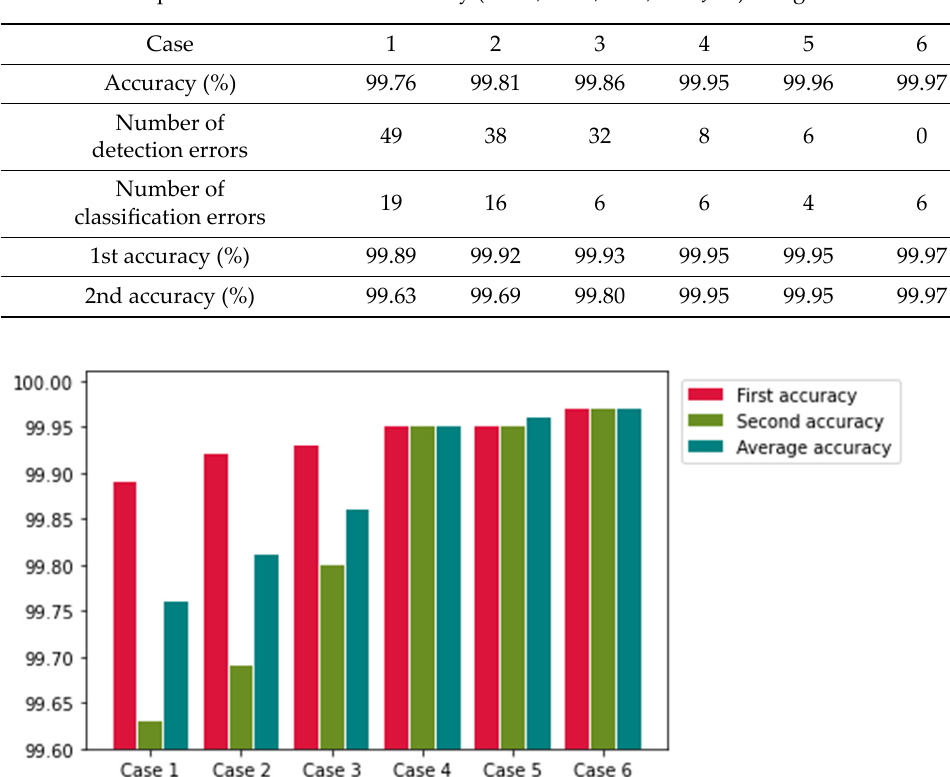
Table 4. Model performance for multi-currency (KRW, USD, INR, and JPY) recognition.